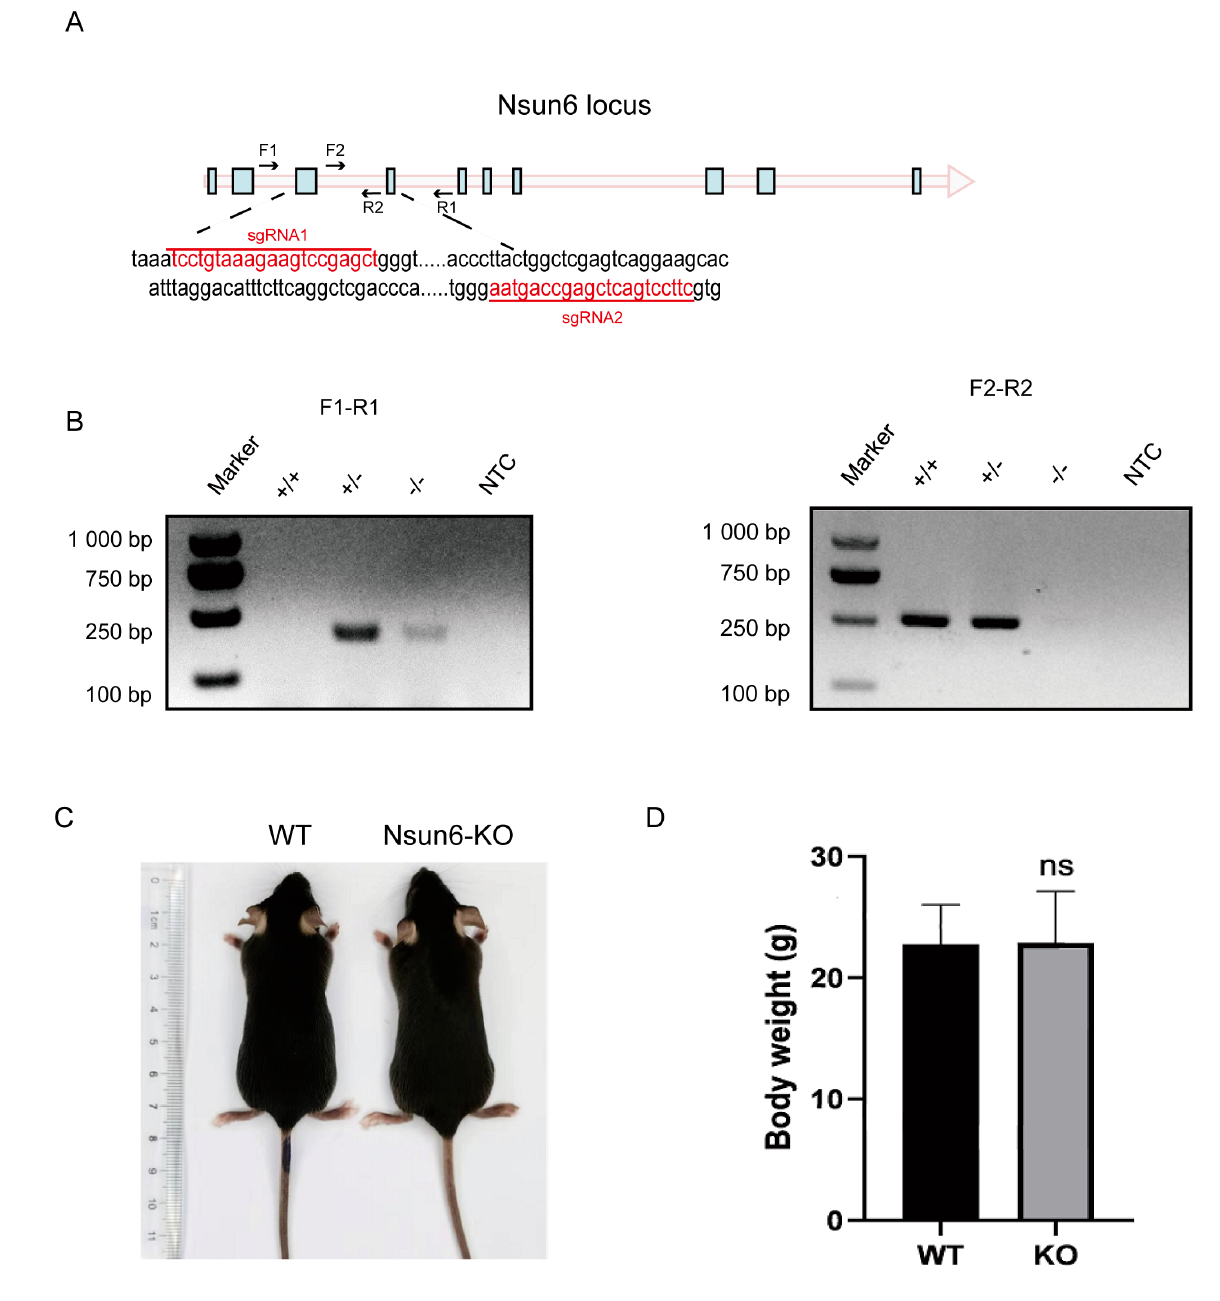
Figure 1. Construction of the Nsun6-KO mouse strain. ( A ) The schematic design of the CRISPR/Cas- mediated Nsun6 KO, where two sgRNAs were used to remove exon 3 and 4 of the gene. Two PCR primer pairs were designed to confirm the genotype. ( B ) The correct genotype of the KO mouse was confirmed: the primer pairs F1-R1 and F2-R2 were used to detect the KO and WT allele, respectively. ( C ) The appearance of Nsun6-KO and WT mice. ( D ) The bodyweight of Nsun6-KO and WT mice at the age of 8 weeks ( n = 5, p >